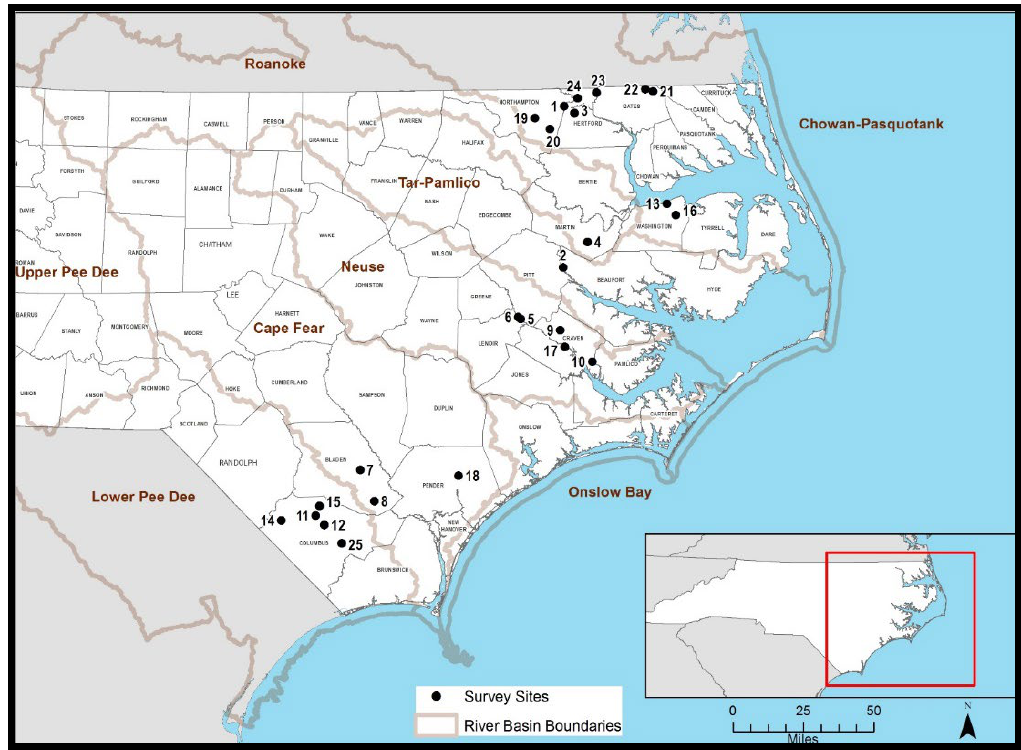
Figure 1. Approximate survey site locations displayed with counties and major river basins of Eastern North Carolina.